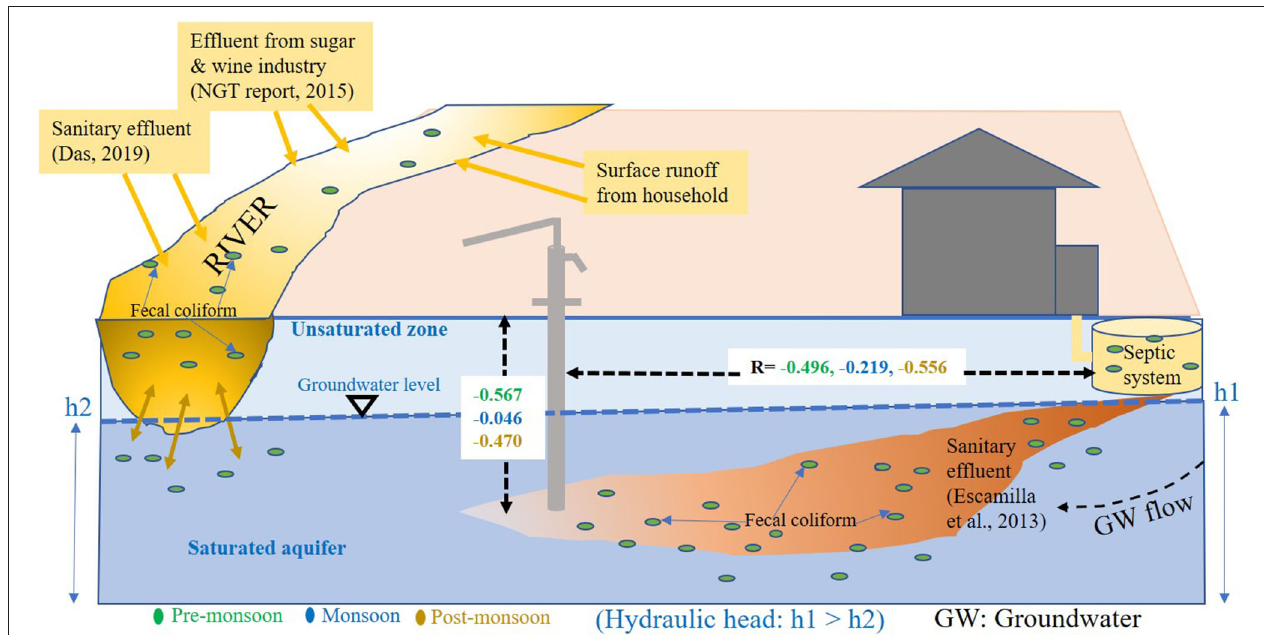
FIGURE 6 | Schematic diagram of groundwater coliform contamination from sanitation and contaminated surface water with statistical significance in different